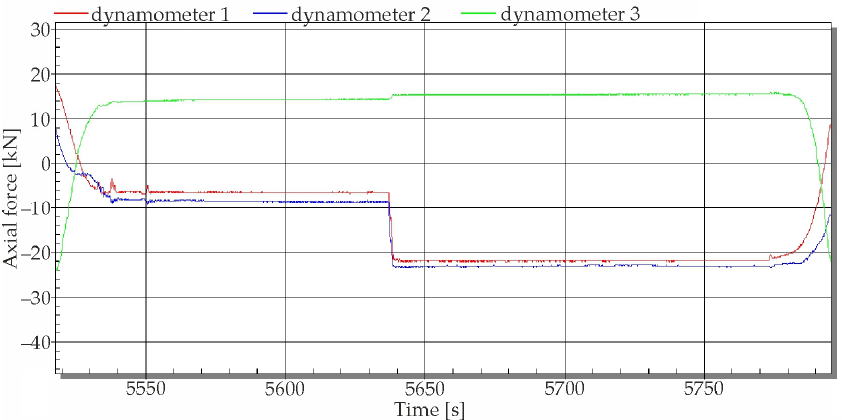
Figure 11. The time courses of the axial forces when removing the empty ladle and rotating the pedestal with the full ladle to the reserve position.